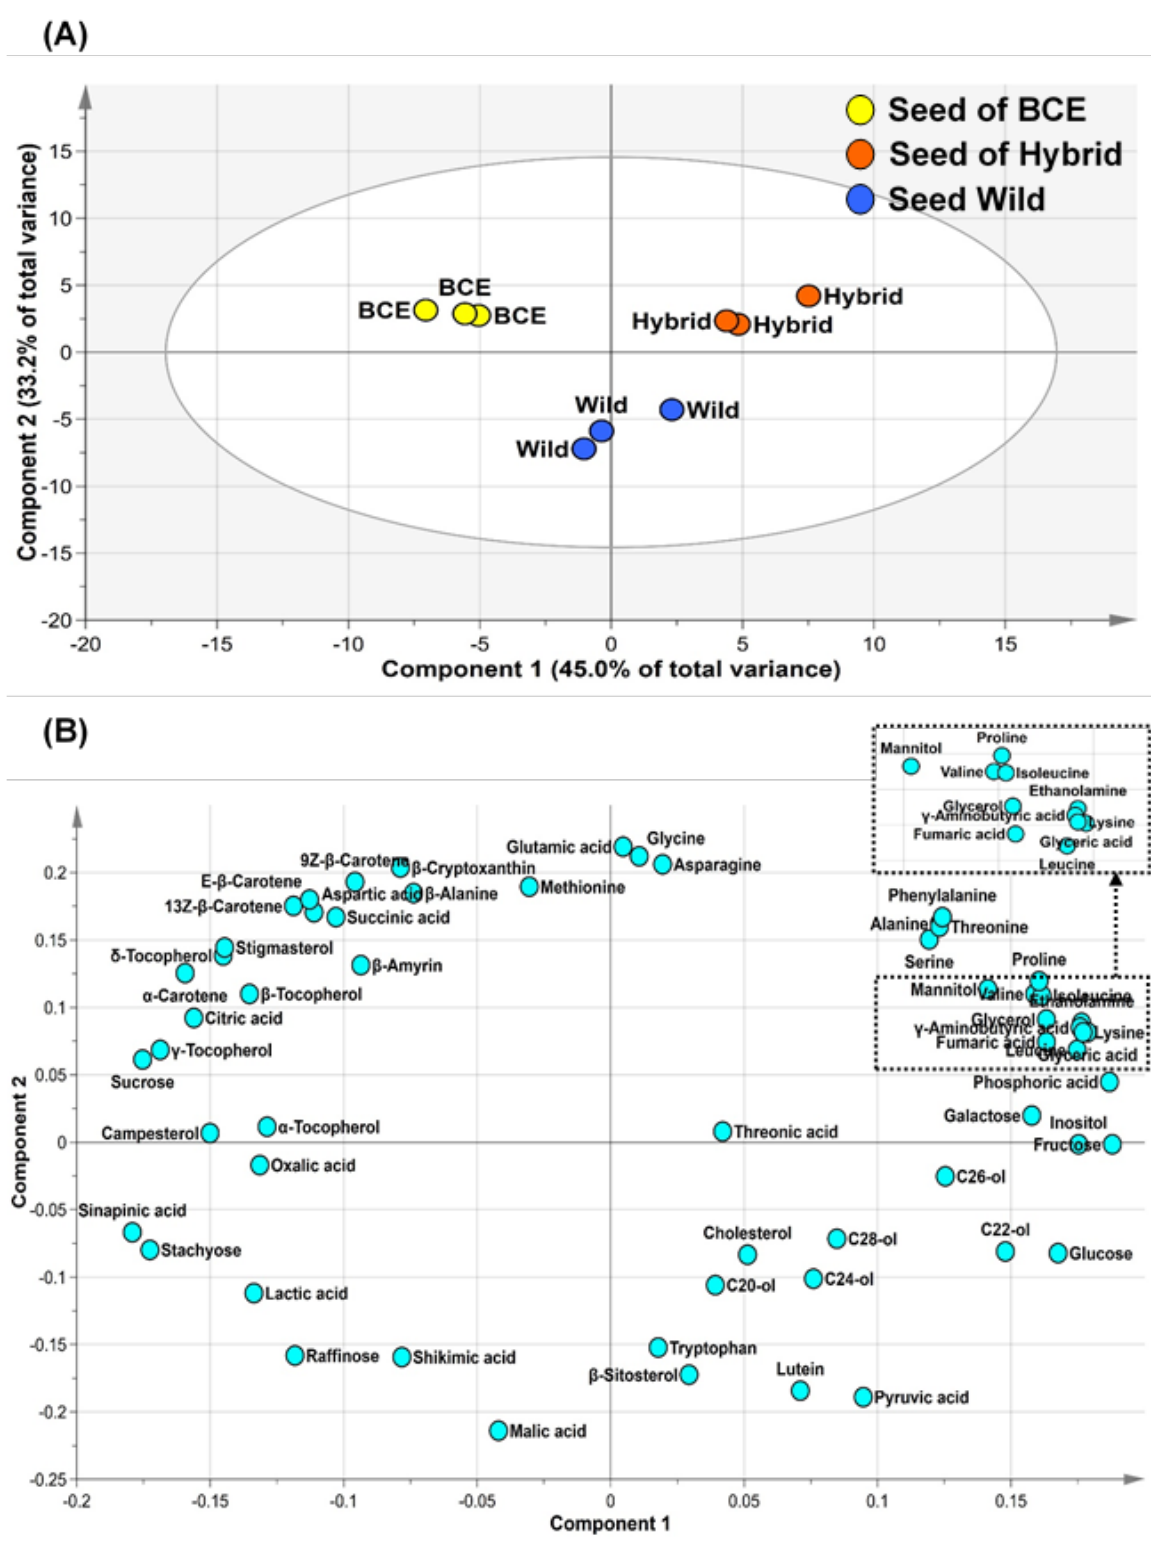
Figure 1. Score ( A ) and loading ( B ) plots of PCA of metabolites extracted from BCE, Hybrid, and Wild seeds.